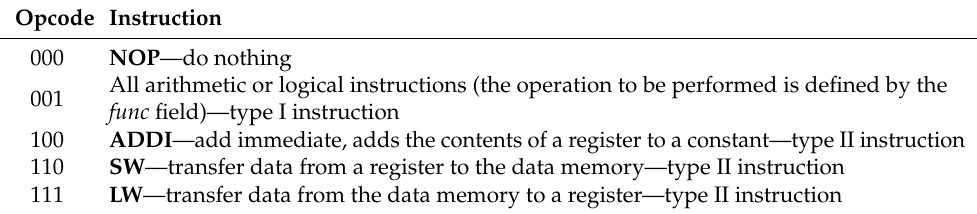
Table 1. Opcode field value for different instructions.